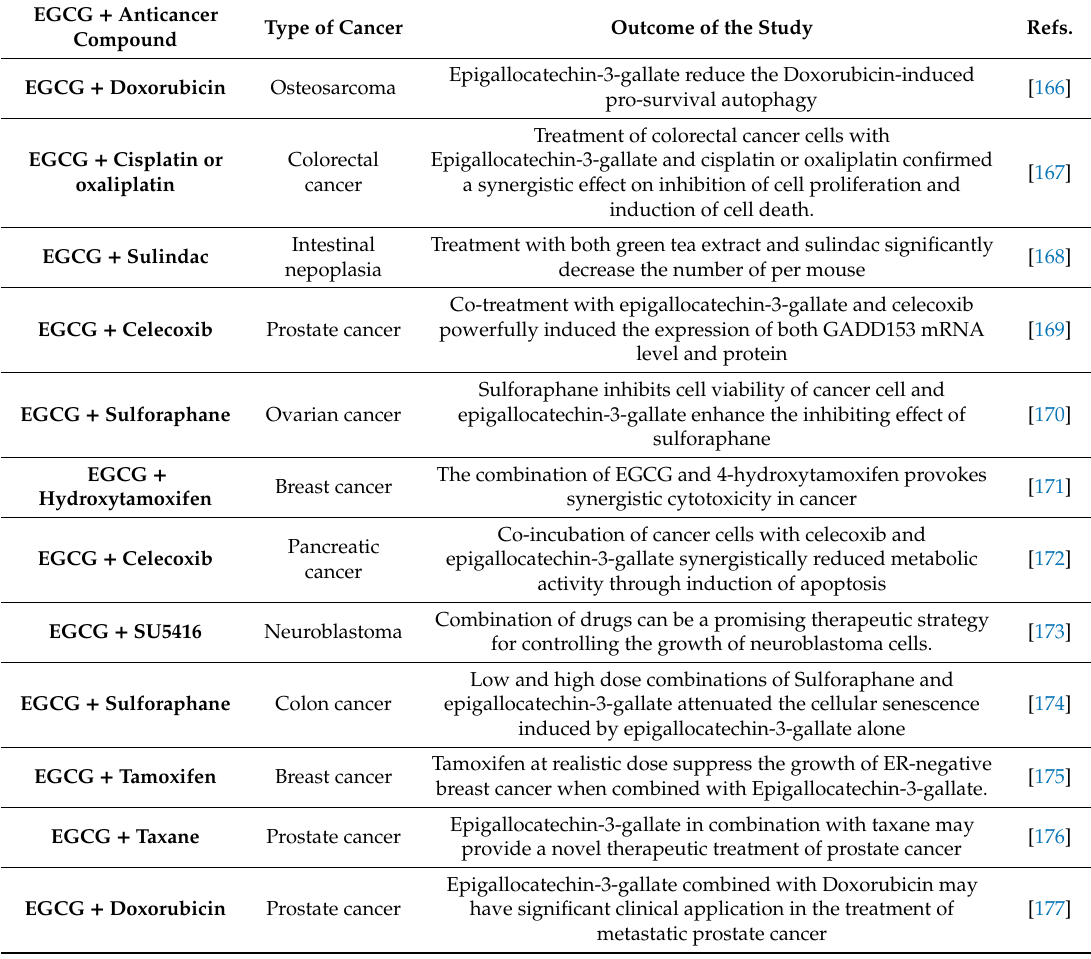
Table 3. Synergistic e ff ects of combination of EGCG and other anticancer drugs.